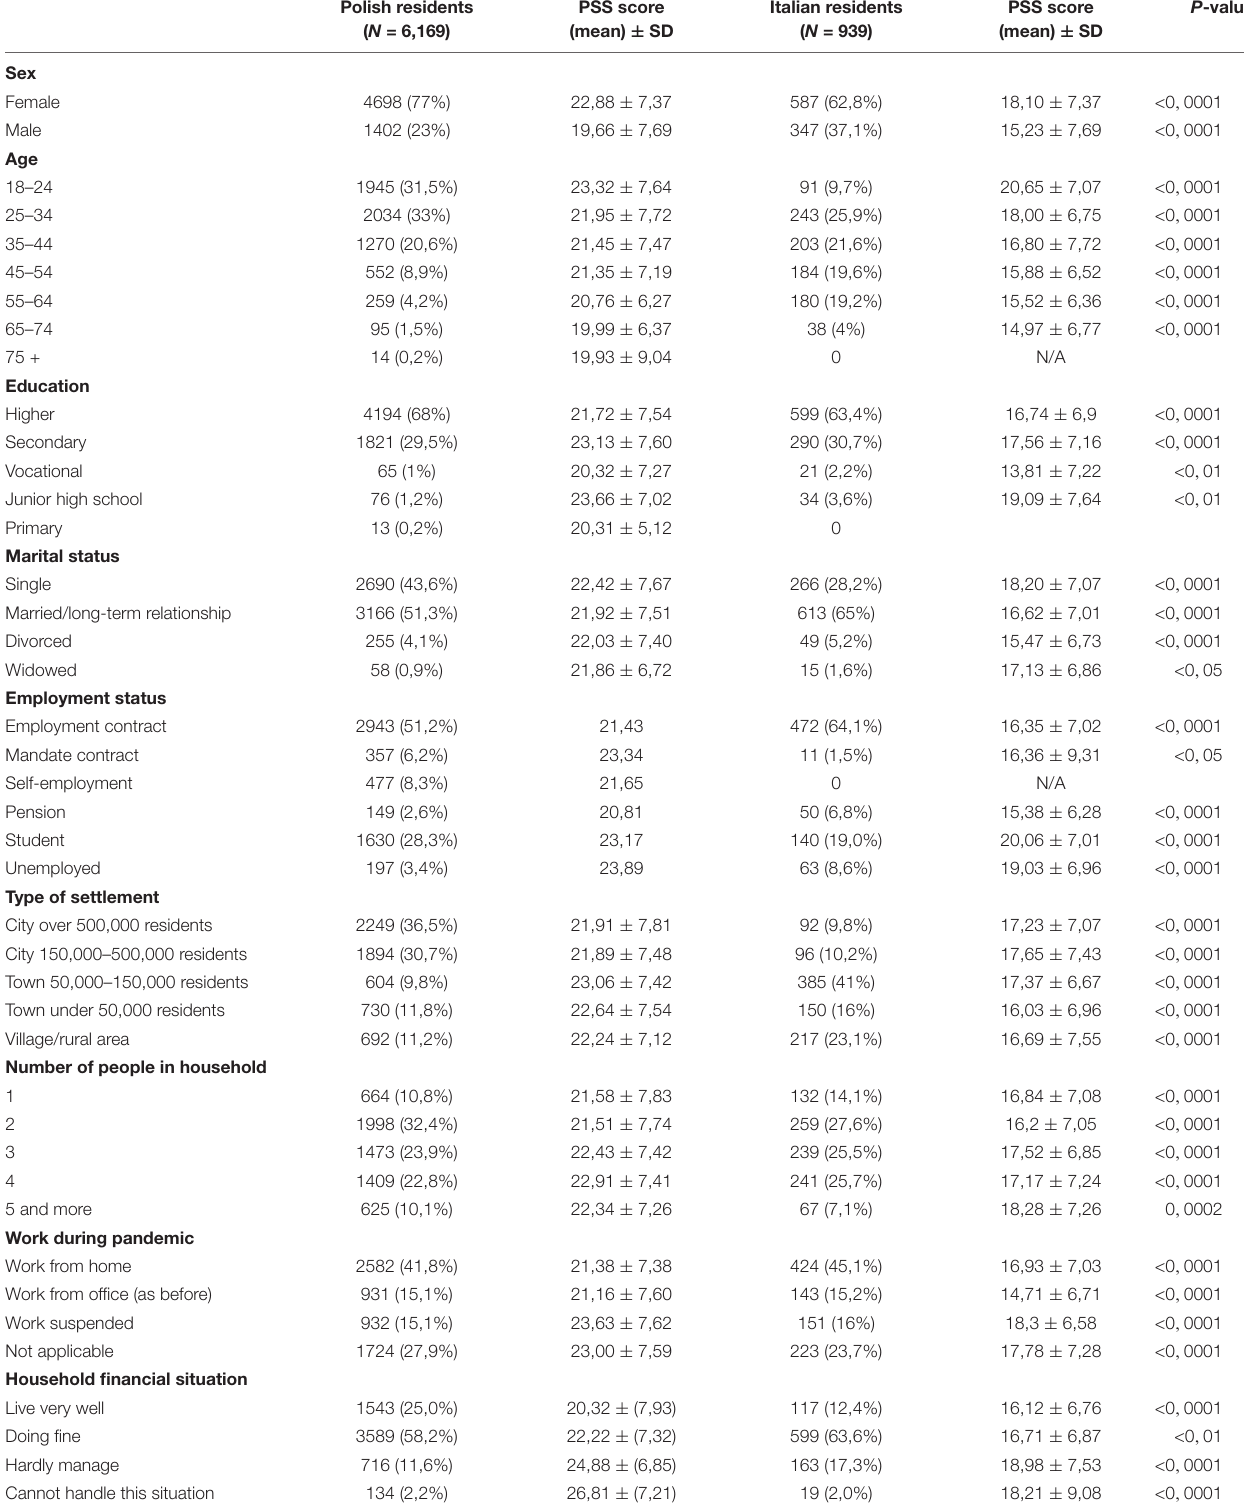
TABLE 1 | Sociodemographic characteristics of the